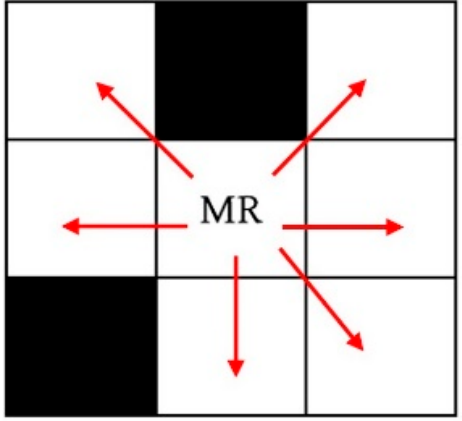
Figure 3. Possible path direction.